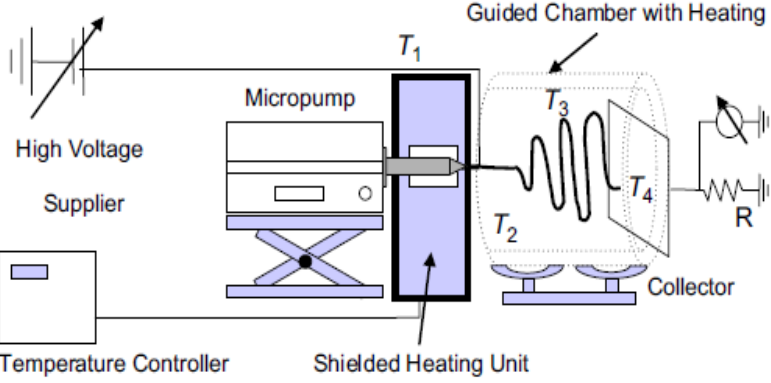
Figure 3. Multi-heating zone melt electrospinning [29].